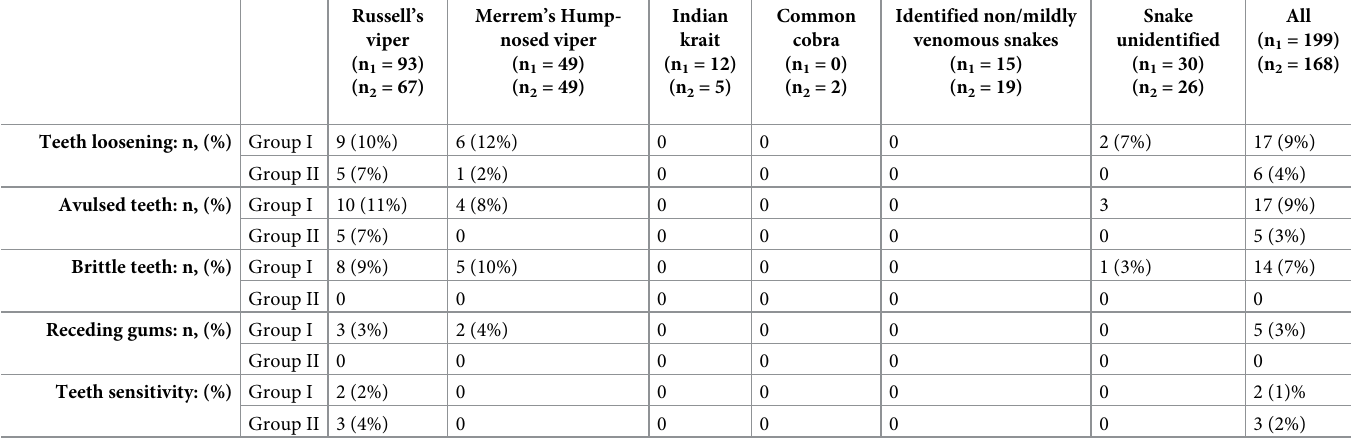
(Table 3) and symptoms related to the oral cavity (Table 4). In group I, 95/199 (48%) patients Table 4. Patients complaints related to the oral cavity that could not be explained